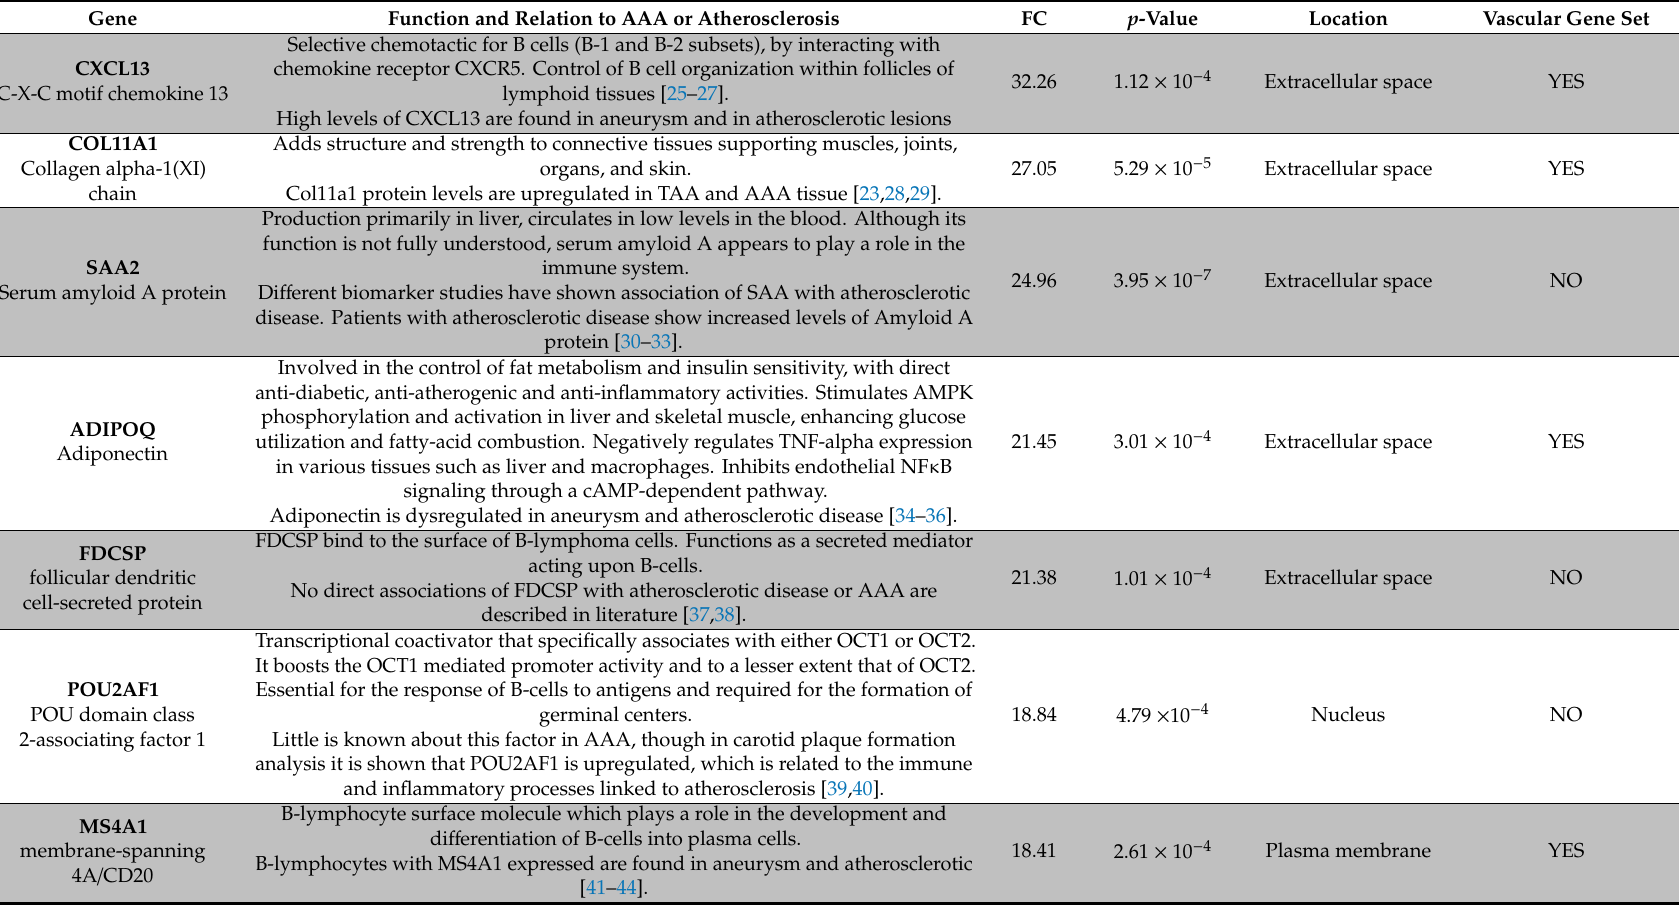
Table 4. Top 10 genes upregulated genes in AAA versus AOD, including their function, fold change (FC), p -value in dataset, location, and presence or absence in the vascular gene